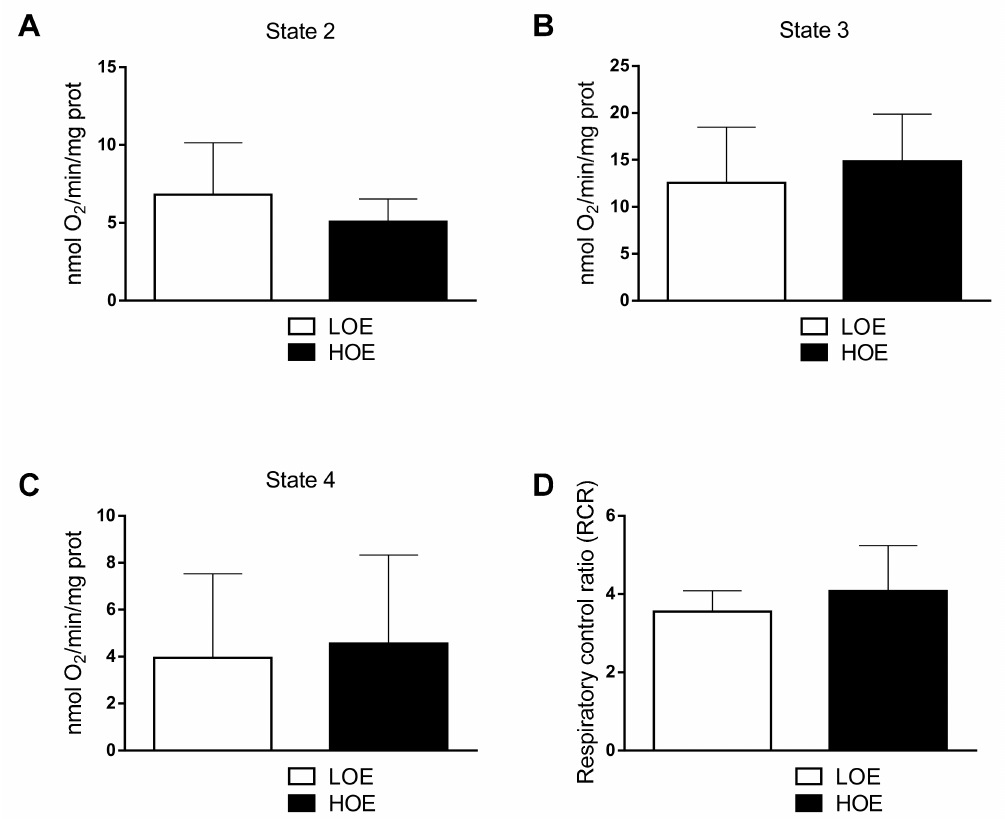
Figure 2. The mitochondrial O 2 consumption is similar in both 3D cardiac spheroids differentiated under LOE and HOE conditions. The mitochondrial O 2 consumption in 12 days old hPSC-CMs (using hiPSC UEFhfiPS1.4 and UB47 lines) differentiated in LOE and HOE conditions was evaluated using the O 2 -k oxygraph (Oroboros Instruments). ( A ) State-2 respiration in hPSC-CMs differentiated under LOE (white bars) and HOE (black bars) conditions. ( B ) State-3 respiration in hPSC-CMs differentiated under LOE and HOE conditions. ( C ) State-4 respiration in hPSC-CMs differentiated under LOE and HOE conditions. ( D ) Respiratory control ratio (RCR) in hPSC-CMs differentiated under LOE and HOE conditions. The number of experiments is 3 independent biological replicates for each bar graph. Data are presented as mean ± SEM. Significance was calculated by Mann-Whitney